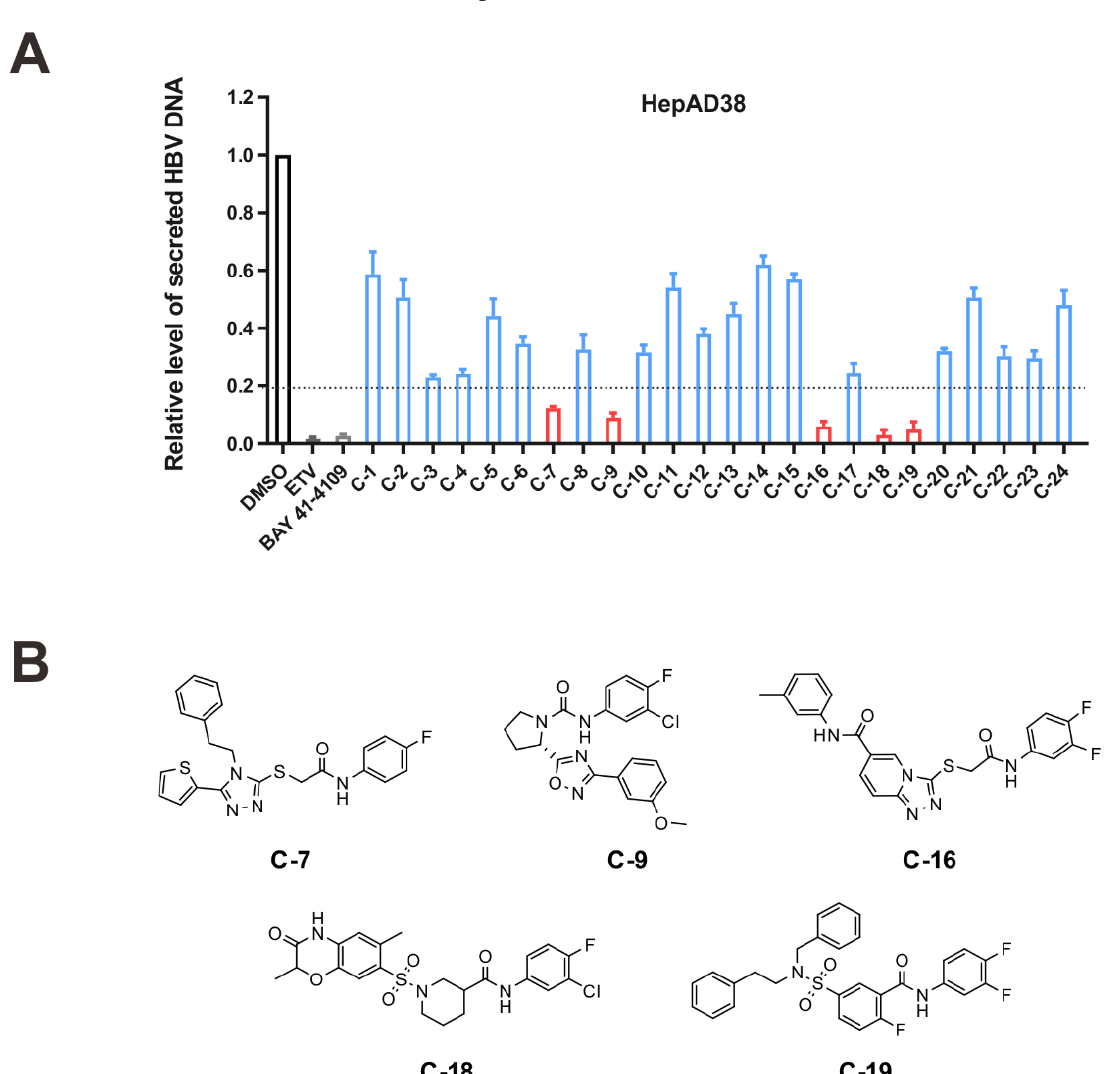
Figure 2. Screening and identification of novel HBV inhibitors. ( A ) Effects of the 24 compounds (C-1–C-24, 20 μM) on secreted HBV DNA in HepAD38 cells. Compounds with significant antiviral activity were defined with a threshold of 20% of DMSO control. ( B ) Structures of the initial hit compounds C-7, C-9, C-16, C-18, and C-19. Data are representative of three independent experiments and are expressed as the mean ± SD.